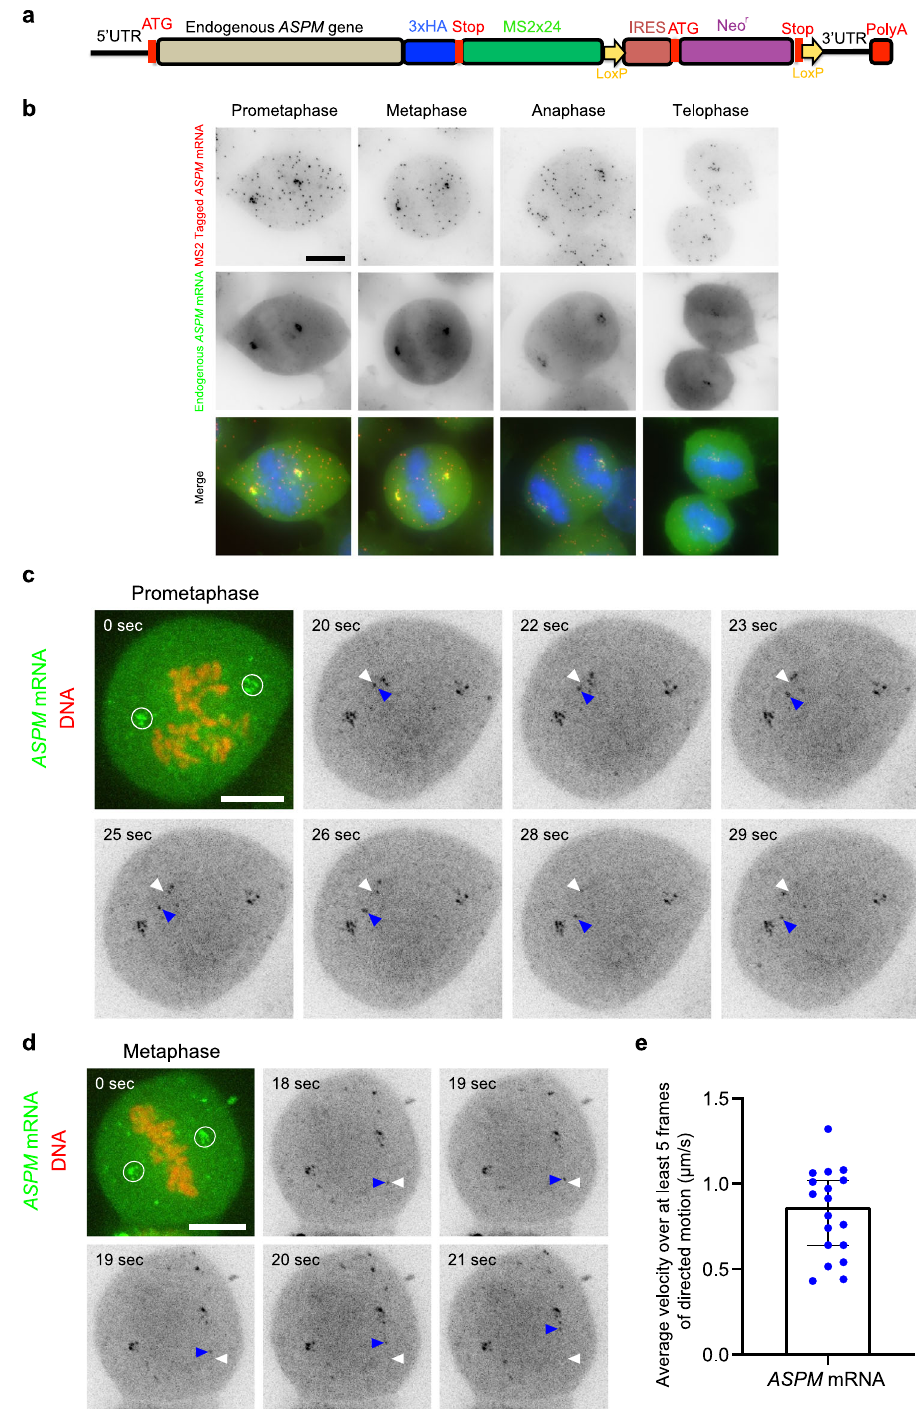
Fig. 5 ASPM mRNAs undergo diffusion, directed movements, and anchoring to spindle poles and fi bers across mitosis. a Schematic representation showing the insertion of 24 MS2 repeats at the end of the ASPM gene using CRISPR-Cas9. HA human in fl uenza hemagglutinin tag, Stop stop codon, IRES internal ribosome entry site, Neo r neomycin resistance, UTR untranslated region, PolyA poly A tail. b Images are micrographs of mitotic HeLa cells with an ASPM-MS2x24 allele. Upper and red: Cy3 fl uorescent signals corresponding to tagged mRNAs labeled by smFISH with MS2 probes; middle and green: Cy5 signals corresponding to the tagged and untagged ASPM mRNA detected by smiFISH with endogenous ASPM probes. Blue: DNA stained with DAPI. Scale bar: 10 microns. c Snapshots of ASPM-MS2x24 cells expressing MCP-GFP-NLS and imaged live during prometaphase. In the fi rst panel, the GFP signal is shown in green and corresponds to ASPM mRNAs labeled by the MS2-MCP-GFP-NLS. The Cy5 signal is shown in red and corresponds to DNA. Scale bar: 10 microns. Time is in seconds. The white circle displays ASPM mRNAs with limited diffusion. In subsequent panels, only the GFP signal is shown and is represented in black. White arrowheads indicate the starting position of an mRNA molecule, while blue ones follow its current position. d Legend as in c but for a cell captured in metaphase. e Bar graph showing the average speed of ASPM mRNA molecules displaying directed motion, calculated over at least fi ve frames (or 2.5s). The bar represents the median and error bars represent a 95% con fi dence interval. Data obtained across three independent